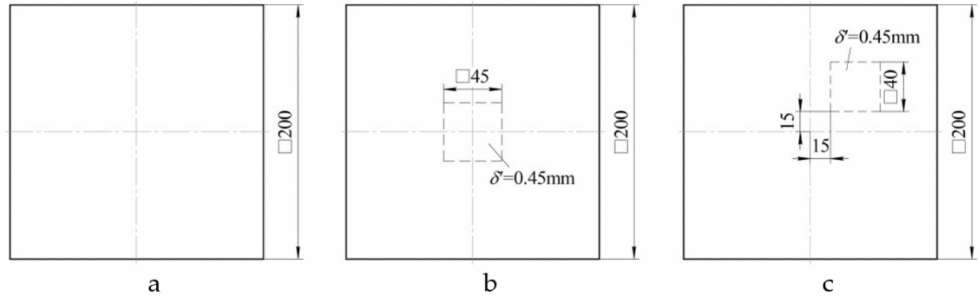
Figure 12. Configuration of three flat plates: of uniform thickness ( a ); with a notch located in the centre ( b ); with a notch located off centre ( c